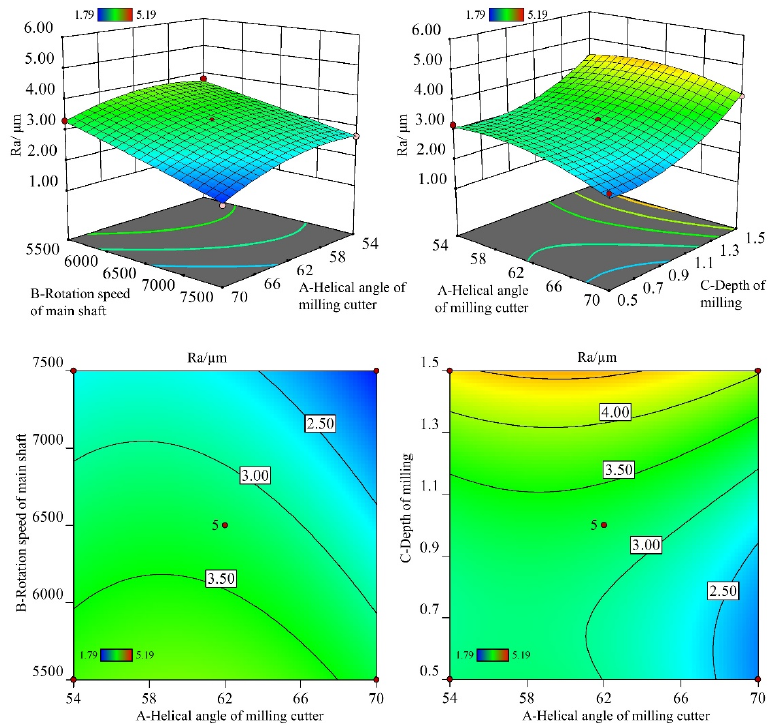
Figure 3. The 3D surface and contour graphs for Ra.